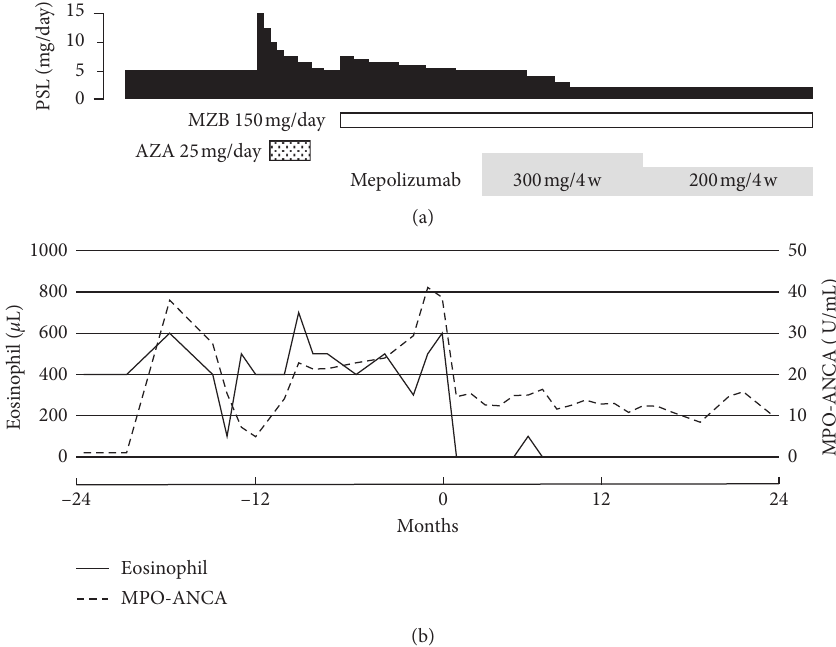
Figure 2: Clinical course. MPO-ANCA: myeloperoxidase-antineutrophil cytoplasmic antibody.